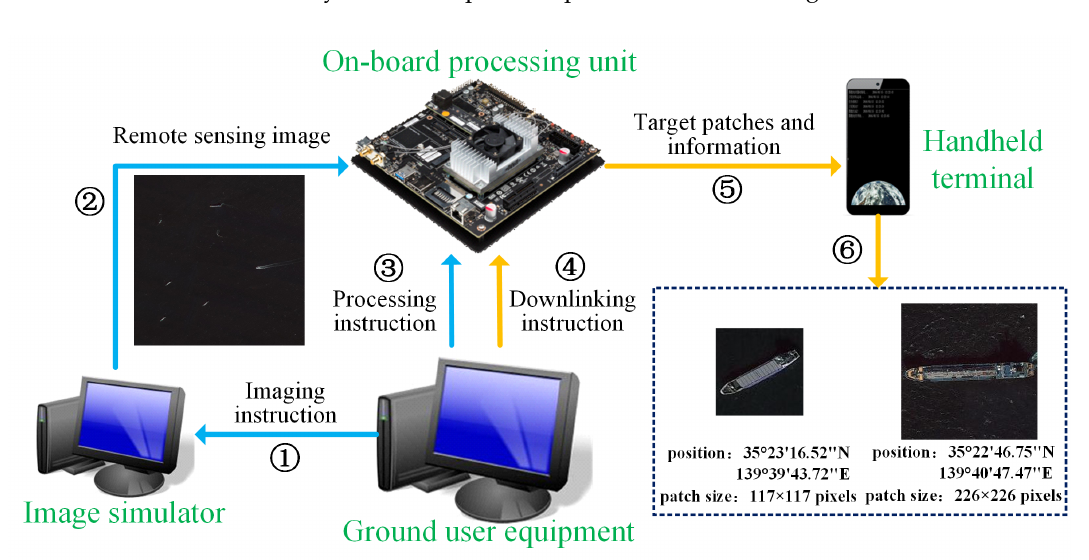
Figure 6. The operation process of the ground demonstration and verification